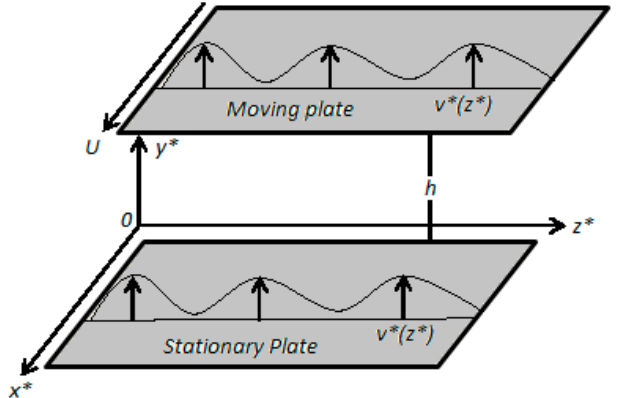
Figure 1. Schematic diagram of the problem.